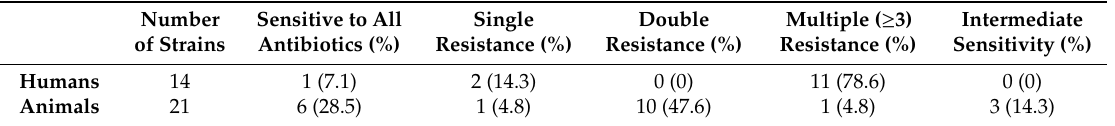
Table 3. Comparison of antibiotic resistance profiles of human and animal isolates.